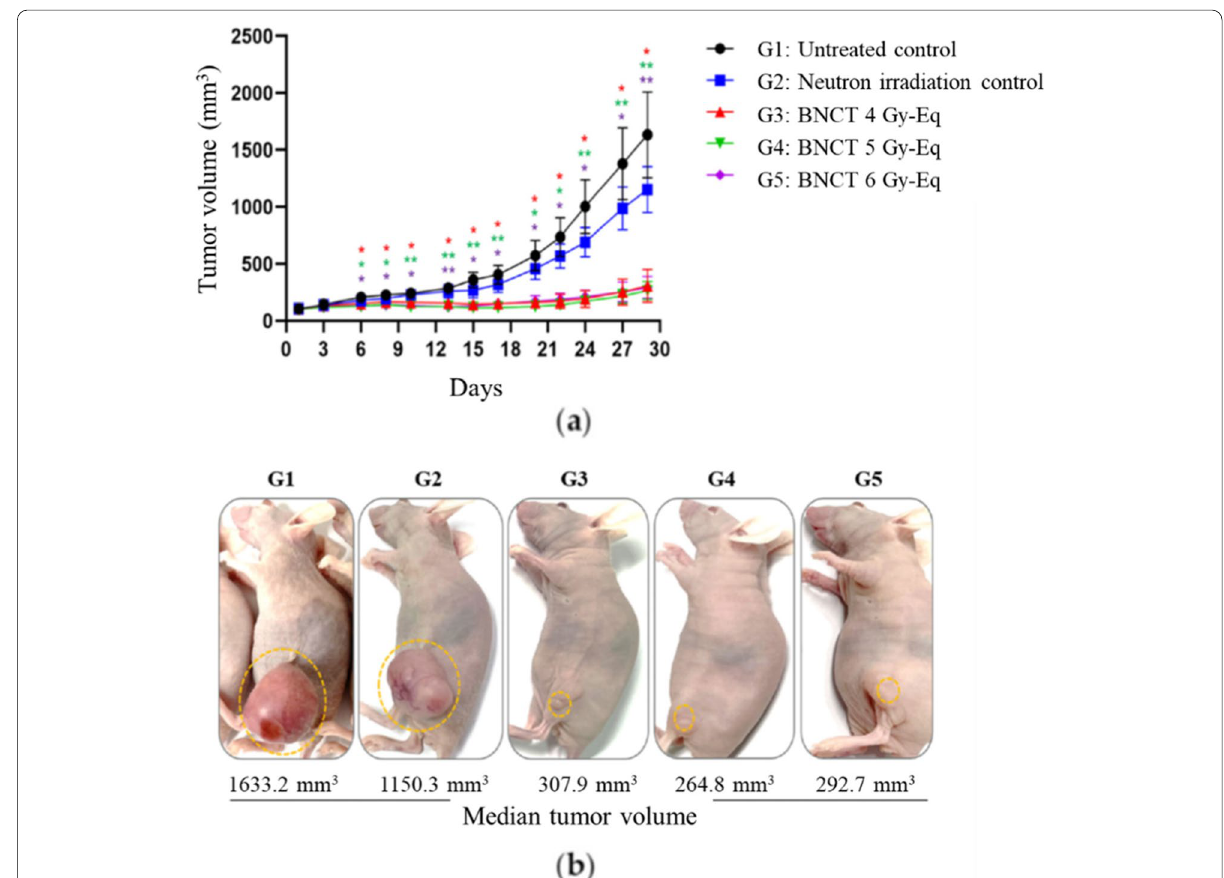
Fig. 23 Efficacy of BNCT on the suppression of tumor growth. BPA 500 and 1000 mg/kg were injected into the U‑87 MG subcutaneous xenograft model and neutron irradiation with equivalent skin doses of 4, 5, and 6 Gy‑Eq. a Tumor growth as a function of time after the finish of neutron irradiation. b The visual tumor appearance at 4 weeks after the neutron irradiation